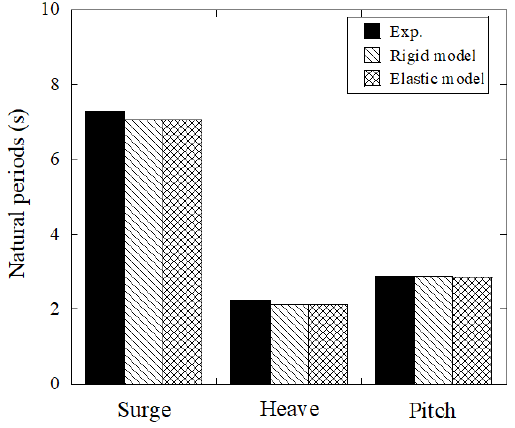
Figure 7. Natural periods of